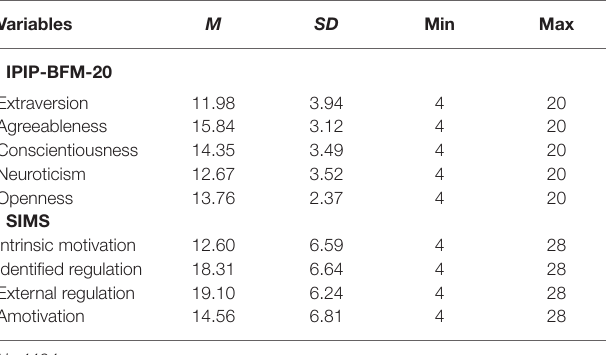
TABLE 4 | Means (M), standard deviation (SD), and minimum (Min) and maximum values (Max) for subscales of the IPIP-BFM-20 and the SIMS. Variables